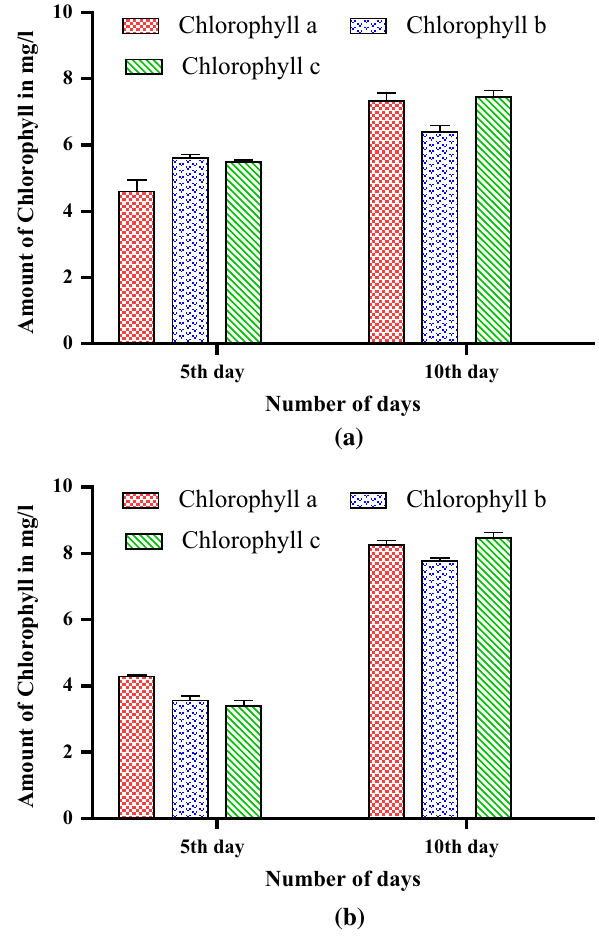
Fig. 8 Chlorophyll estimation of Chlorella sp. SRD3 treated effluent a BHEL area and b Walajapet